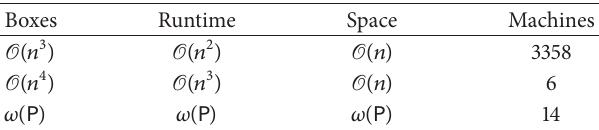
Table 1: Distribution of those TMs in (3,2) space of which we had to compute the corresponding dimension over their complexity classes. By 𝜔( P ) we denote the little 𝜔 notation of the class of polynomials and hereby collect any superpolynomial behavior in one bucket. Boxes Runtime